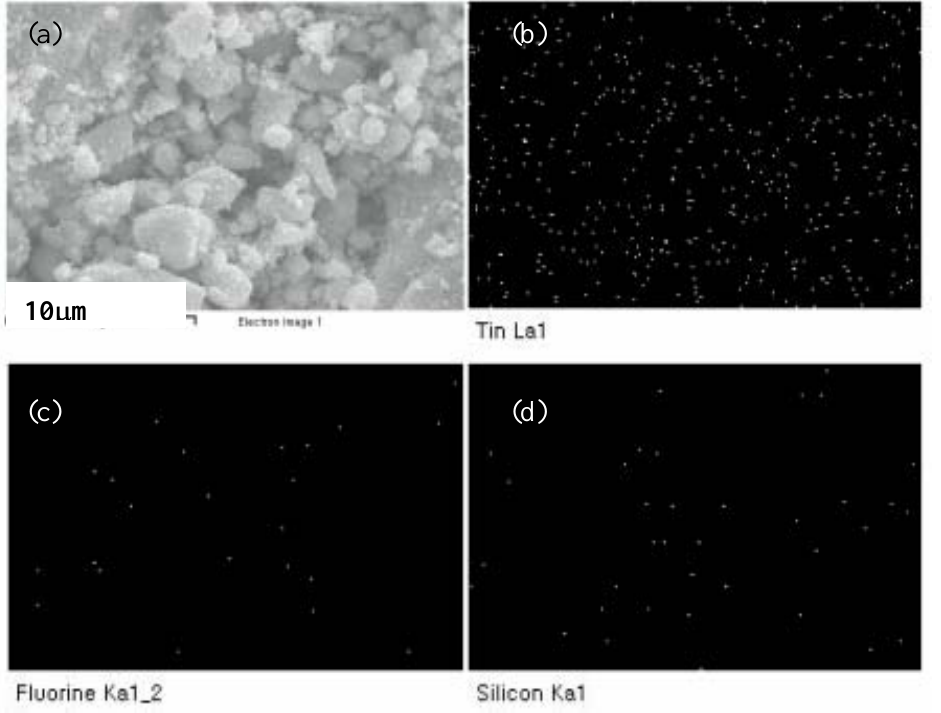
Figure 3. SEM photograph and EDAX of the SiO